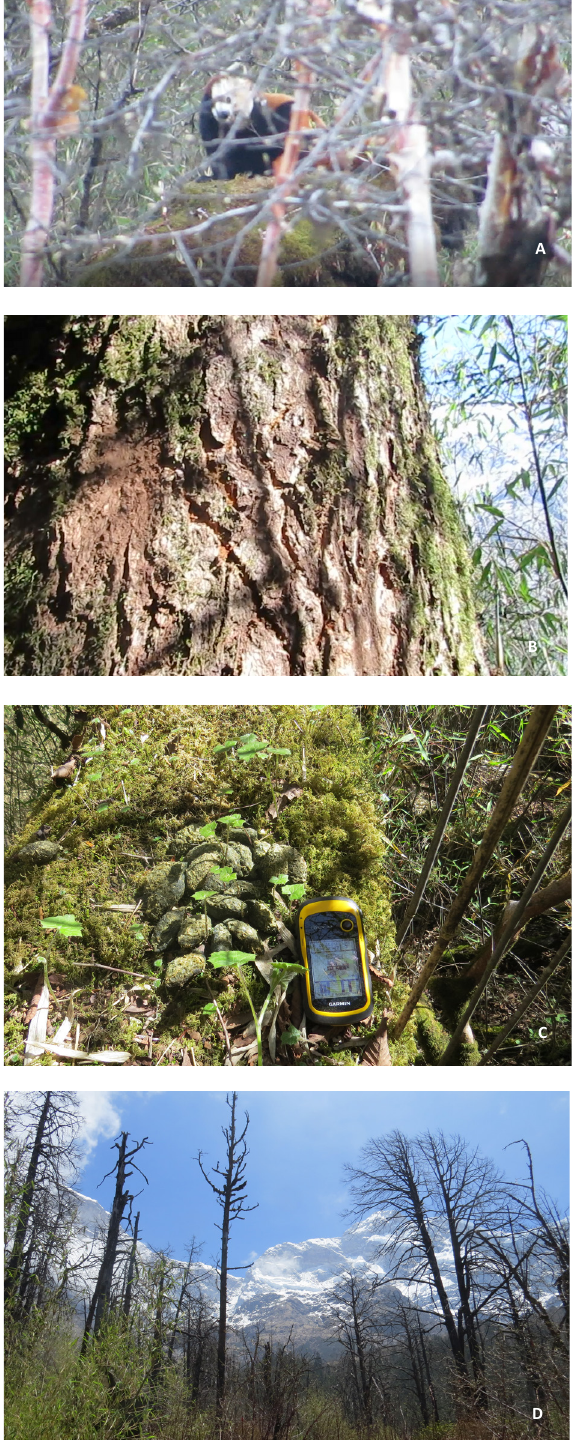
Figure 2. A— Ailurus fulgens photographed at Nafada Khola, Bhulbhule VDC, Lamjung District | B—Distinctive Red Panda scratch marks on a tree trunk at Nafada Khola | C—Fresh Red Panda scats on a tree limb at Nafada Khola | D—Red Panda habitat at Nafada Khola showing an understorey of Slender bamboo Drepanostachyum falcatum . © Ganesh